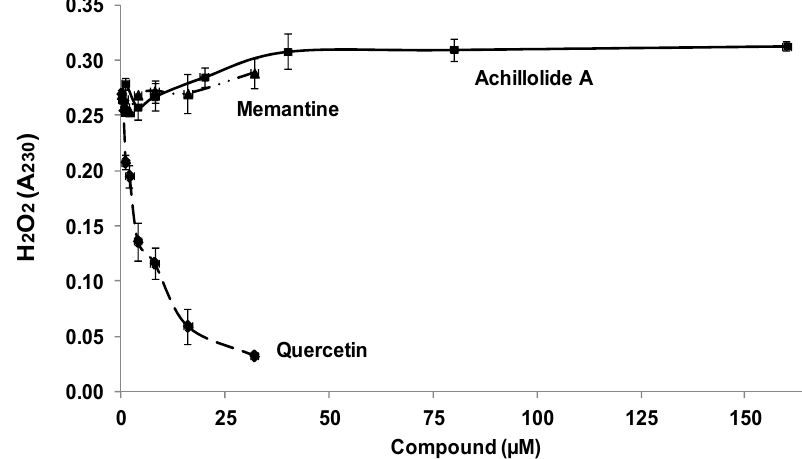
Figure 2. Hydrogen peroxide scavenging ability. For study of H 2 O 2 scavenging activity, 1 mM H 2 O 2 and different concentrations of achillolide A, quercetin, or memantine were co-incubated in PBS. Optical density was measured 10 min later. The results are means ± SEM of two experiments performed in duplicates ( n = 4).